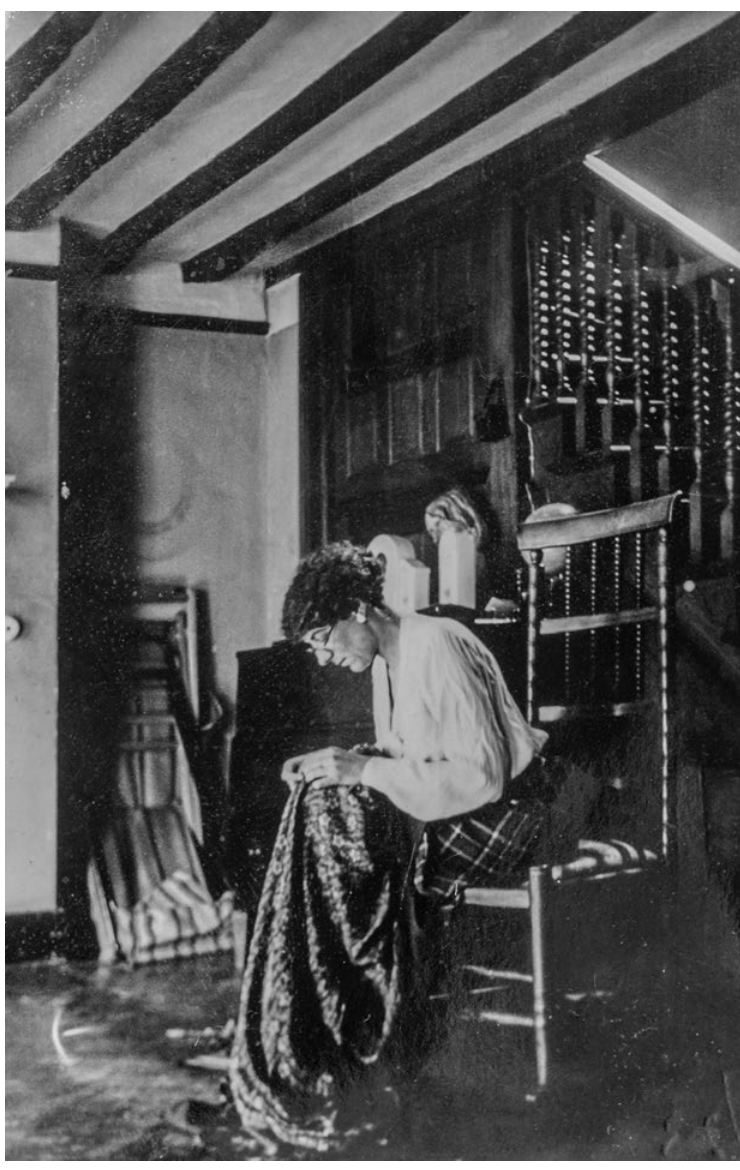
Figure 8.8 Sylvia Townsend Warner. Courtesy of Dorset County